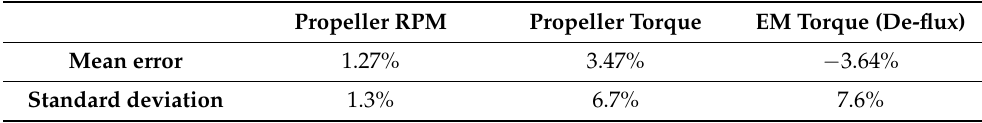
Figure 7 . Test ( a ) experimental and calculated speed curves; ( b ) experimental and calculated torque curves. Table 5. Test 1 simulation error and error standard deviation.